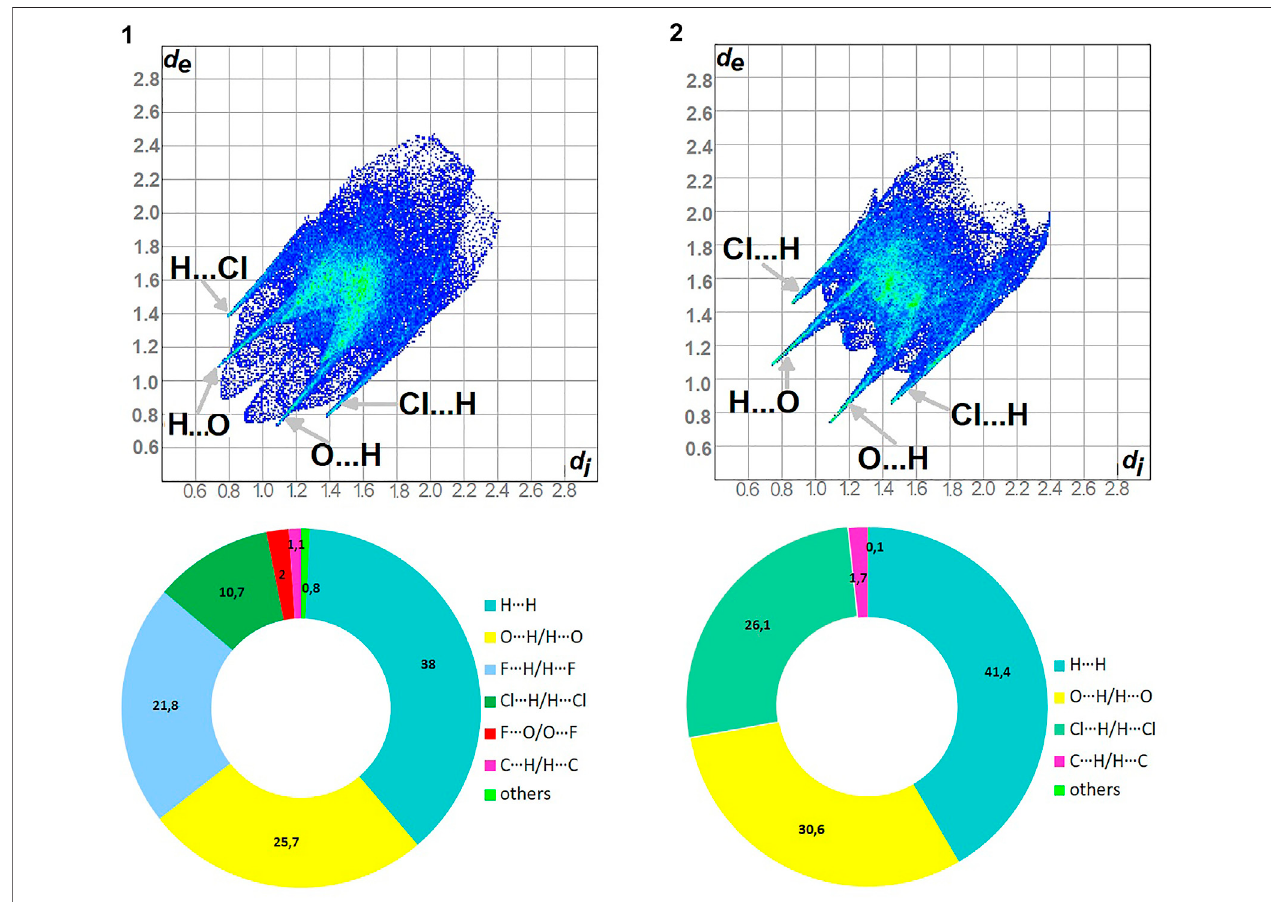
FIGURE 5 | Fingerprint Plots and relative percentage contributions of the diverse supramolecular interactions to the HSs for analyzed crystals (others signi fi es contacts below 1%).